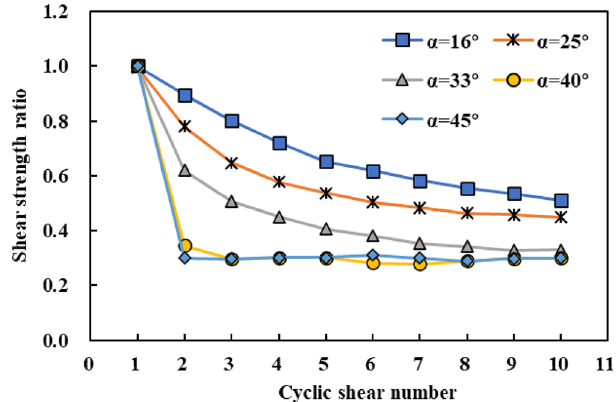
Figure 4. Change in shear strength ratio of joint surfaces with different undulation angles with cyclic shear times under a normal stress of 0.8